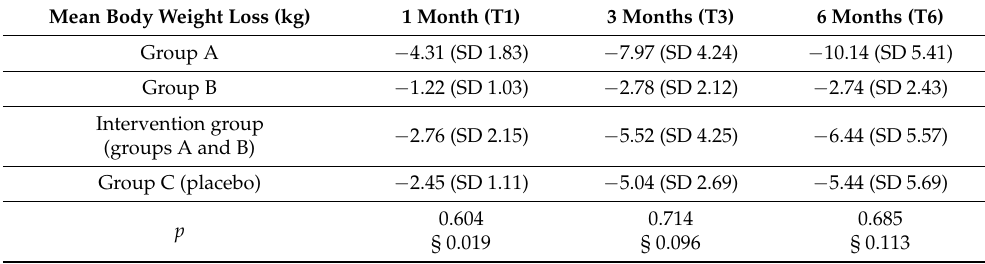
Table 4. Mean body weight loss expressed in kg. Results are expressed as mean values of groups A (high dosage—15 mg HT/day), B (low dosage—5 mg HT/day) and C (placebo) at time points T1, T3 and T6. The p -values express the statistical difference between the intervention and placebo groups. The § marker is used for comparisons between groups A and C. SD: standard